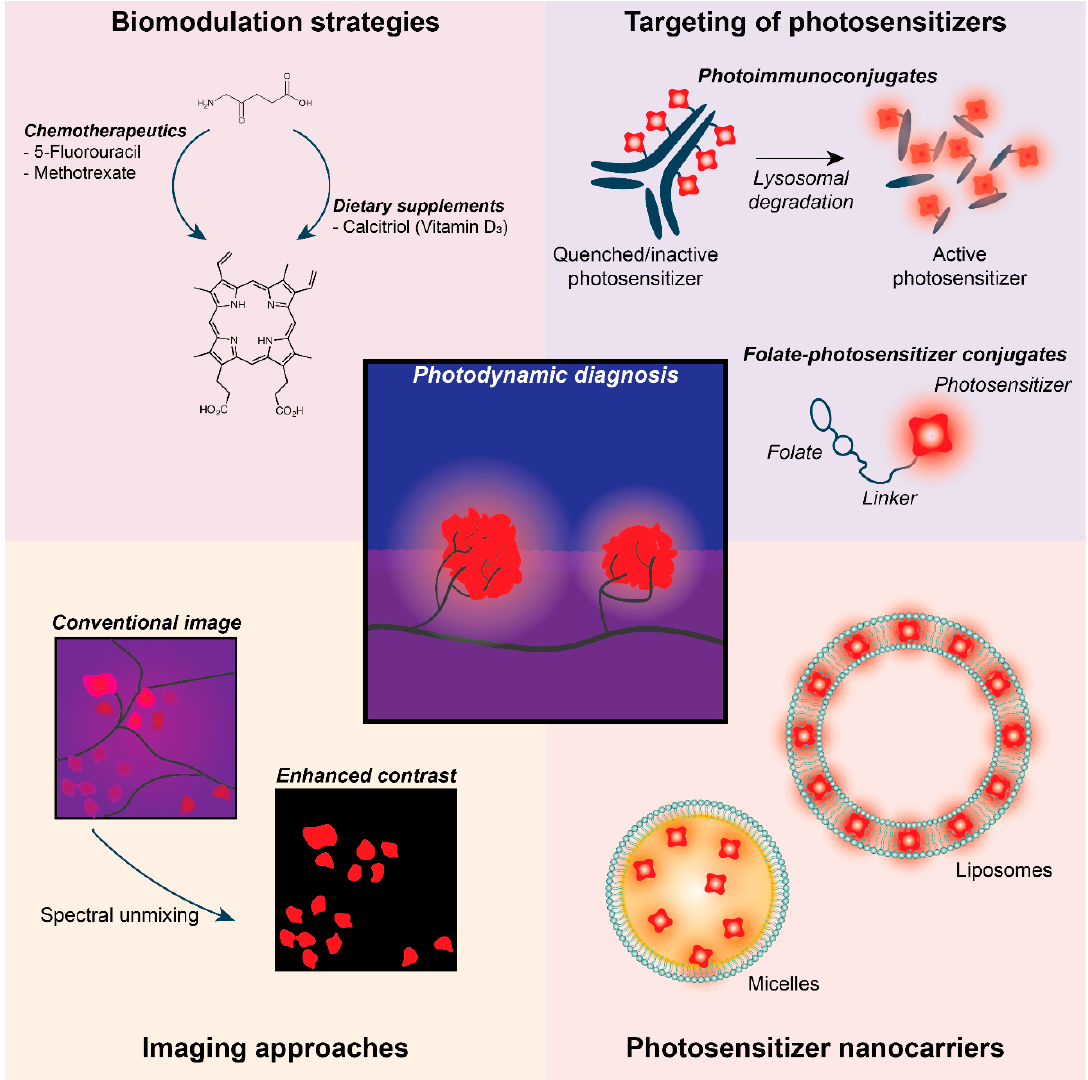
Figure 2. Promising strategies to improve the efficacy of PDD for PCAR. Innovative approaches have demonstrated the promise of biomodulation strategies in augmenting PpIX biosynthesis in cancer cells, in the targeting of photosensitizers, in the development of nanocarriers, and in improving imaging